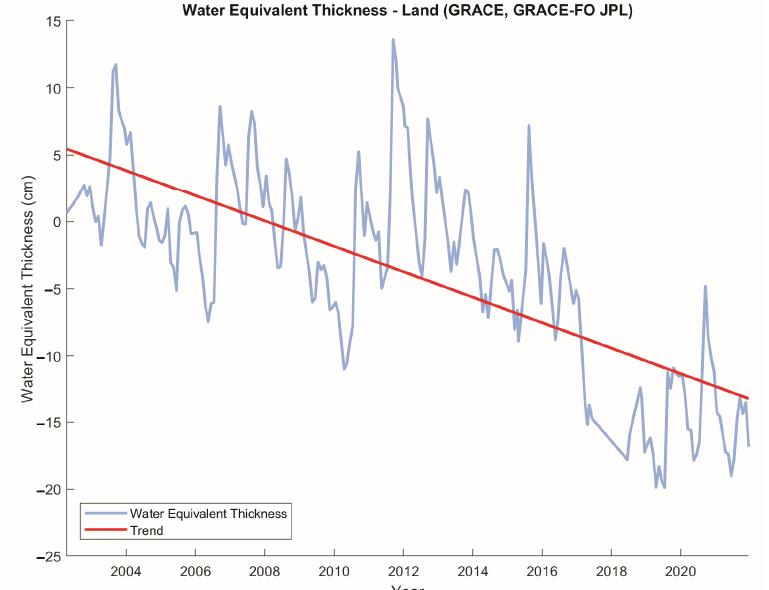
Figure 9. Water Equivalent Thickness on land in the Karachi region from April 2002 to December 2021.